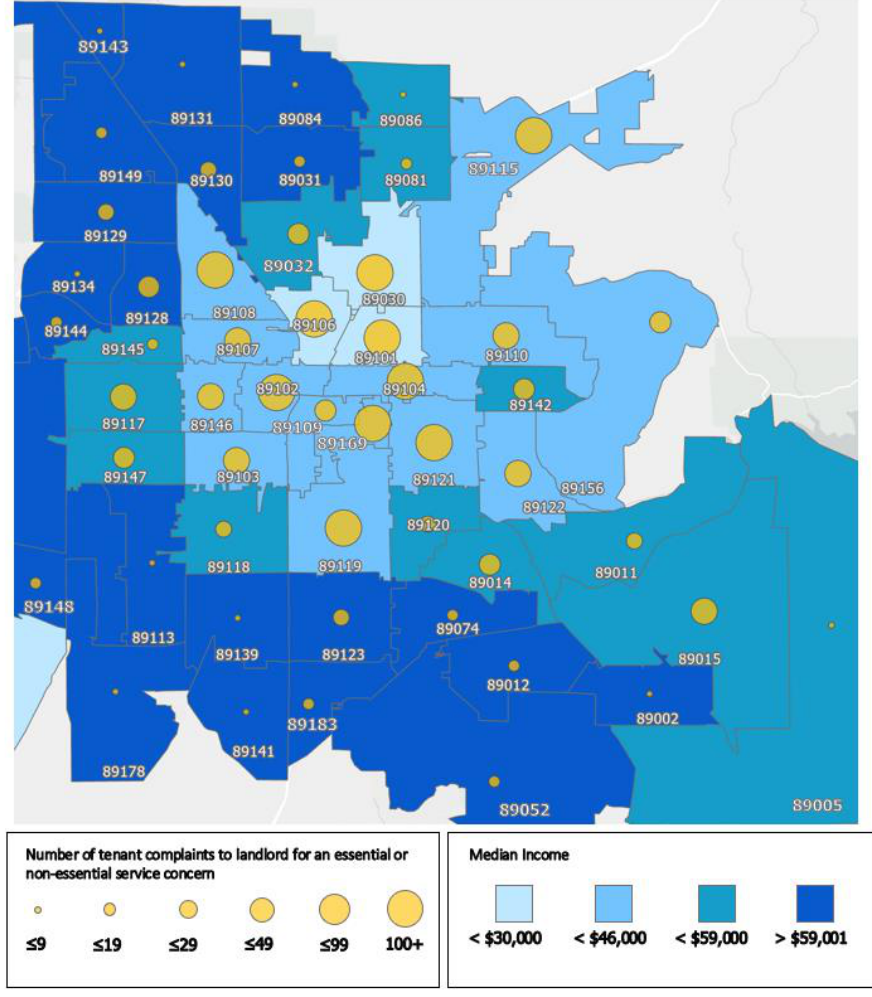
Figure 1. Housing habitability concerns from 2865 calls made to the Clark County Landlord – Tenant Hotline (CCLTH) between May 2011 and April 2013 by median income for each ZIP code. Table 1. Summary of complaints by ZIP code median income and essential and nonessential ser- vices from 2865 calls made to the Clark County Landlord – Tenant Hotline (CCLTH) between May 2011 and April 2013.